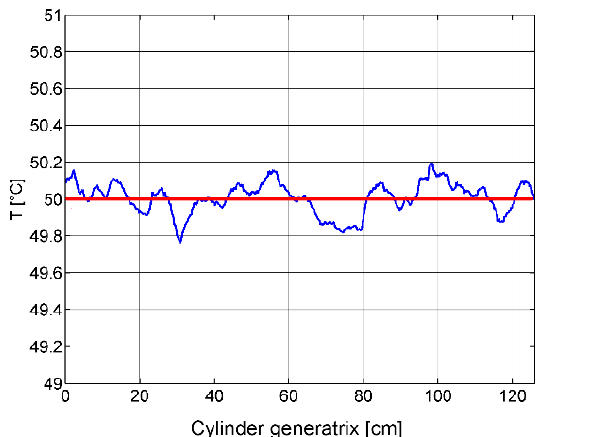
Figure 20. Temperature distribution along the forming cylinder over time.